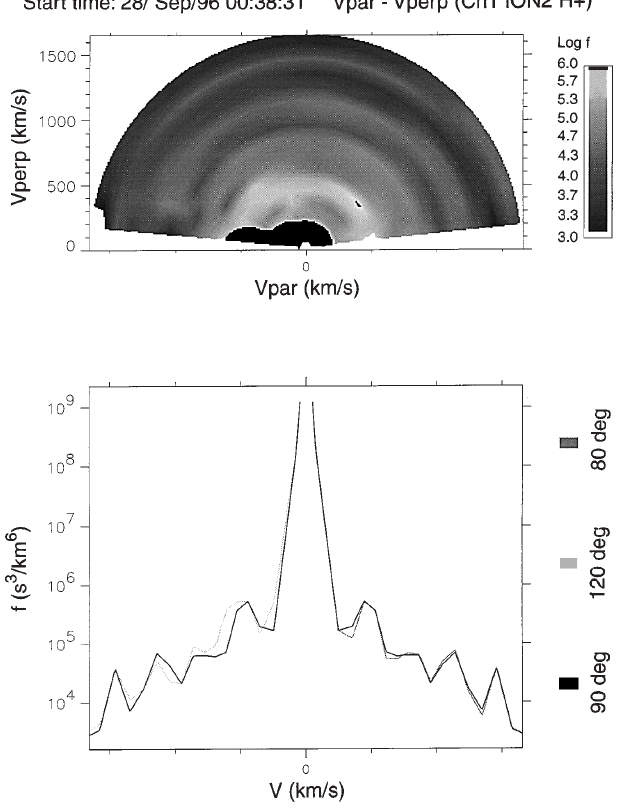
Fig. 12. Top: distribution function of the protons during a 1-min interval starting at 00:38:31 UT. Bottom: cuts of the f (cid:133) v three pitch angles (30 (cid:176) , 90 (cid:176) , and 160